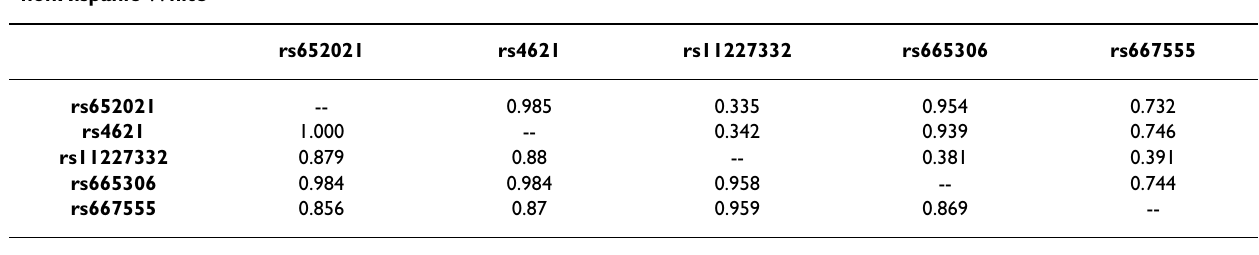
Table 3: Pairwise LD of CFL1 SNP markers in different ethnicities nonHispanic